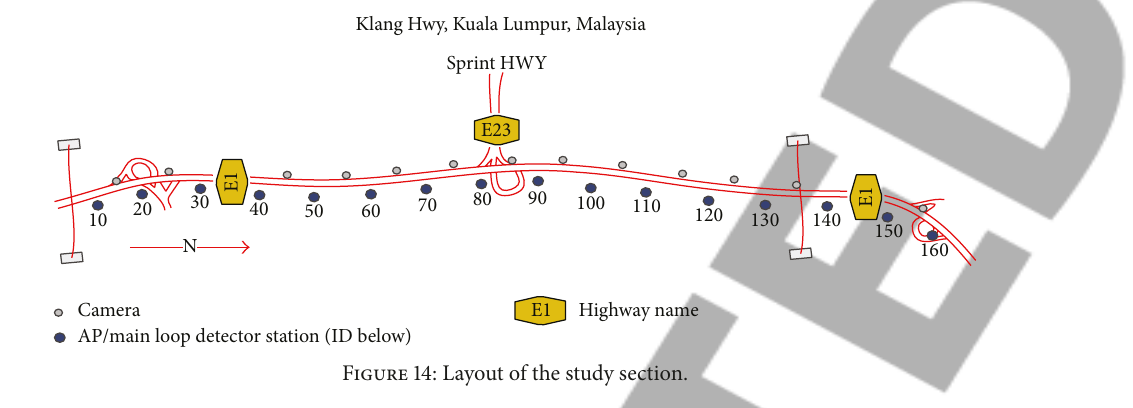
Figure 14: Layout of the study